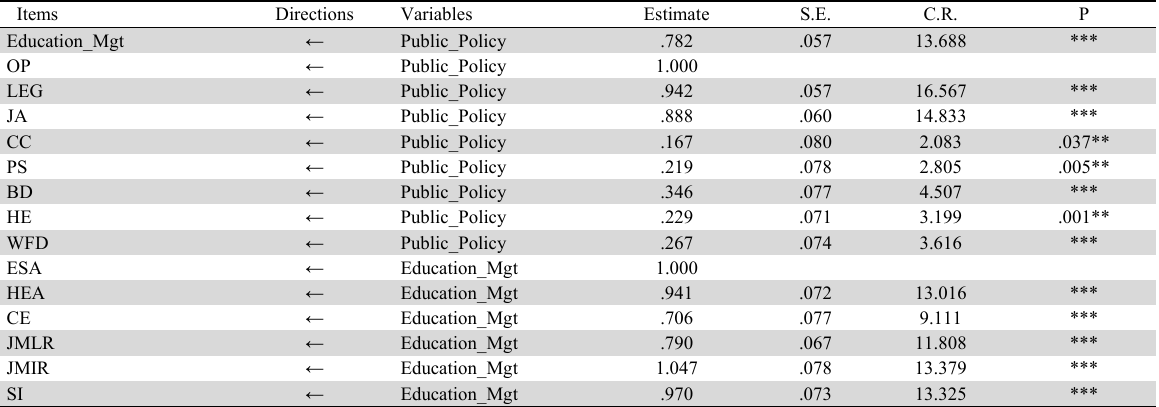
Regression values for Public Policy and Education Management